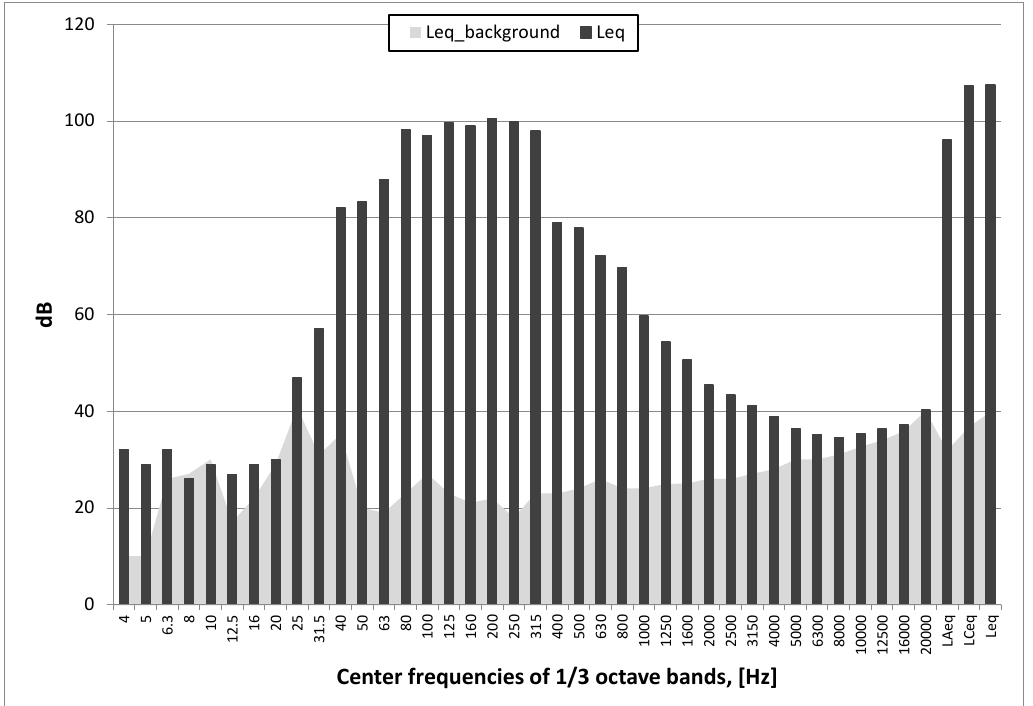
Figure 9. Test No. I: spectrum of averaged sound pressure levels in 1 / 3 octave bands; sine sweep in the range of 30 – 300 Hz and background noise (Leq_background); stand 5.